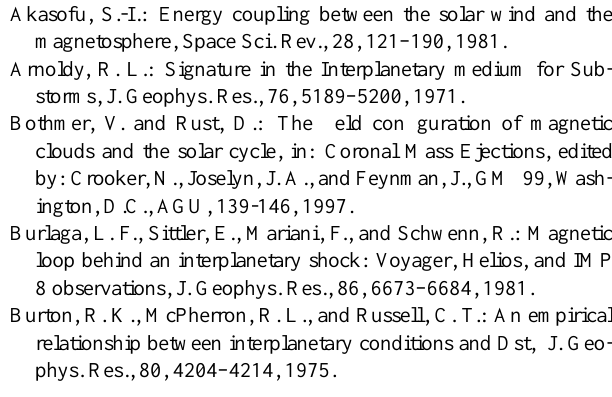
Table 3. The occurrence frequency of MCs which caused a geo- magnetic storm during solar quiet and active periods.